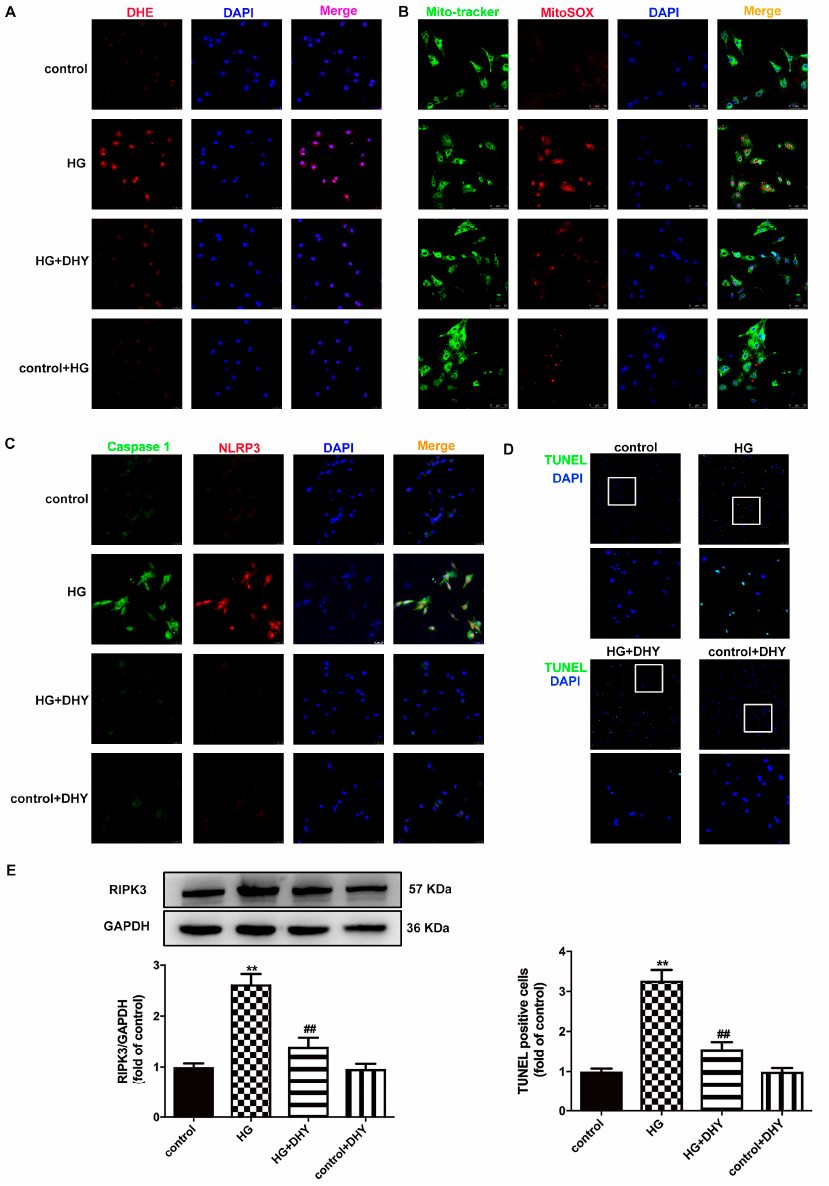
Figure 6. DHY inhibited oxidative stress, inflammasome and necroptosis in cardiomyocytes with high glucose stimulation. ( A ) The representative images of cardiomyocyte with DHE staining (red) and nuclei with DAPI staining (blue) (bar = 25 μ m). ( B ) The representative images of cardiomyocyte with MitoSOX staining (red), mitochondria localization with Mito-tracker staining (green) and nu- clei with DAPI staining (blue) (bar = 50 μ m). ( C ) Caspase 1 was immunofluorescence stained with Alexa Fluor 488-conjugated IgG (green), NLRP3 with Cy3-conjugated IgG (red), and nuclei with DAPI staining (blue) (bar = 25 μ m). ( D ) The representative images of cardiomyocyte with TUNEL staining (green), nuclei with DAPI staining (blue) (bar = 100 μ m). TUNEL-positive cells were quan- tified. ( E ) Expression of RIPK3 protein. ** p < 0.01 versus control, ## p < 0.01 versus HG, n = 6. 3.7. DHY Failed to Alleviate Diabetic Cardiomyopathy in STZ-Induced SIRT3-KO Mice Next, SIRT3-KO mice were used to investigate the possible critical role of SIRT3 on the effects of DHY against DCM. Our results showed that there was no significant im- provement of cardiac function, myocardial hypertrophy, fibrosis or myocardial injury in STZ-induced SIRT3-KO mice after DHY treatment (Figure 7). It indicated that DHY pro- tected against DCM in a SIRT3 dependent manner.